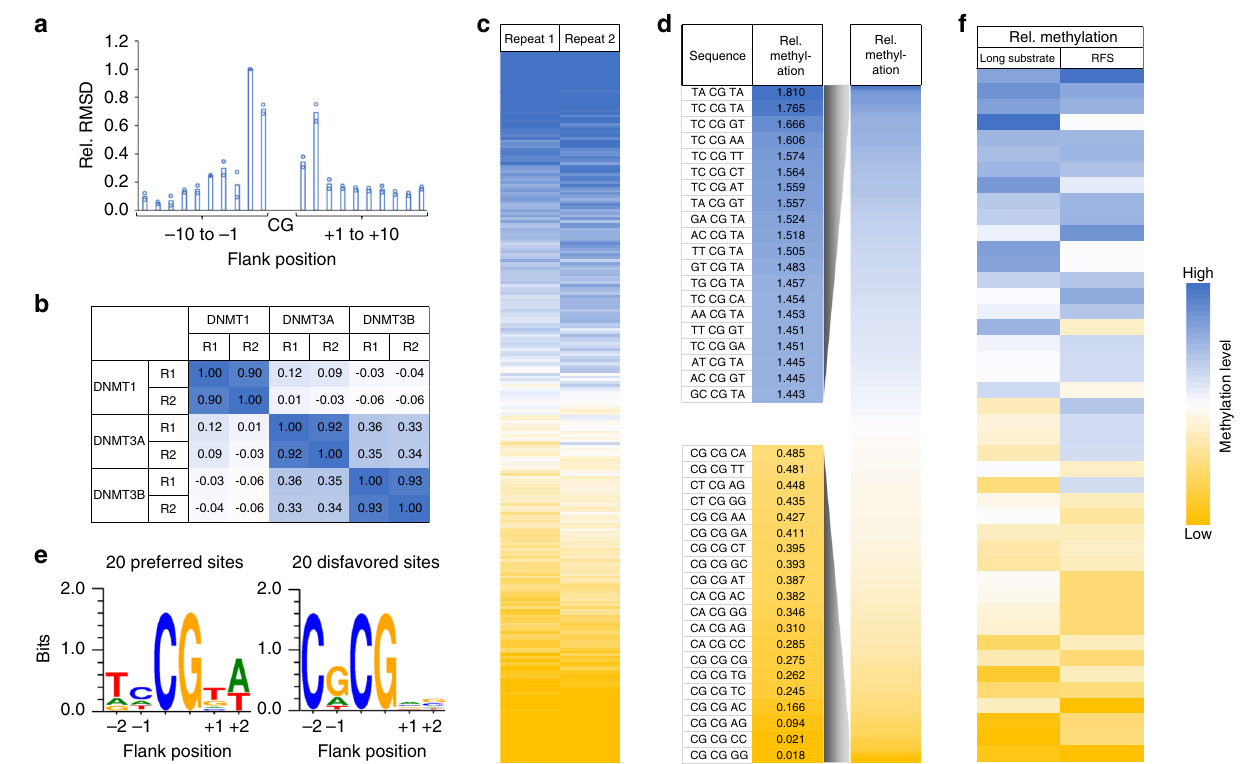
Fig. 3 Deep enzymology analysis of the fl anking sequence preferences of DNMT1. a Relative base preferences of DNMT1 at the − 10 to + 10 fl anking positions surrounding the CpG site. The numbers refer to the root mean squared deviations (RMSD) of the observed/expected base composition at each site among the methylated sequence reads, normalized to the highest effect observed at position − 2. The bars show averages of two independent experiments. b Methylation levels were obtained from two experimental repeats (R1 and R2), averaged for all NNCGNN fl anking sites and the Pearson correlation coef fi cients ( r values) of the pairwise comparison of the data sets were determined. DNMT3A and DNMT3B data were taken from our previous study for comparison 25 . c The methylation levels of NNCGNN sites of both repeats of the DNMT1 methylation reaction displayed as heatmap to show the strong correlation of both data sets (see also Supplementary Fig. 3b). d Heatmap of the methylation levels of NNCGNN fl anking sites ordered by decreasing DNMT1 activity. The outlines show the 20 most favored or disfavored fl anking sites. e Sequence logos of the 20 fl anking sites most favored or disfavored by DNMT1. f Comparison of the NNCGNN methylation levels determined for the 44 CpG sites on the long substrate (long substrate) with the methylation levels determined for the corresponding NNCGNN sites in random fl ank library methylation experiment (random fl ank substrate — RFS). The image shows the methylation levels of individual NNCGNN sites as heatmap. The p value of the correlation is 1.25 × 10 − 4 . The p value is based on the Pearson correlation coef fi cient ( r -factor) and the Z -statistics of the distribution of r -factors determined after randomization of one of the data sets. See also Supplementary Fig. 4b for a box plot comparison. Source data are provided as a Source Data fi le.